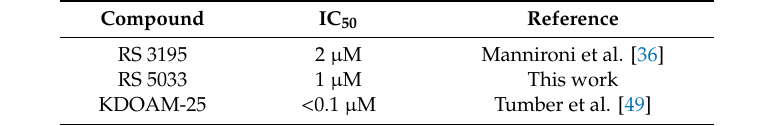
Table 2. In vitro IC 50 of RS 3195, RS 5033 and KDOAM-25 toward KDM5 enzymes.